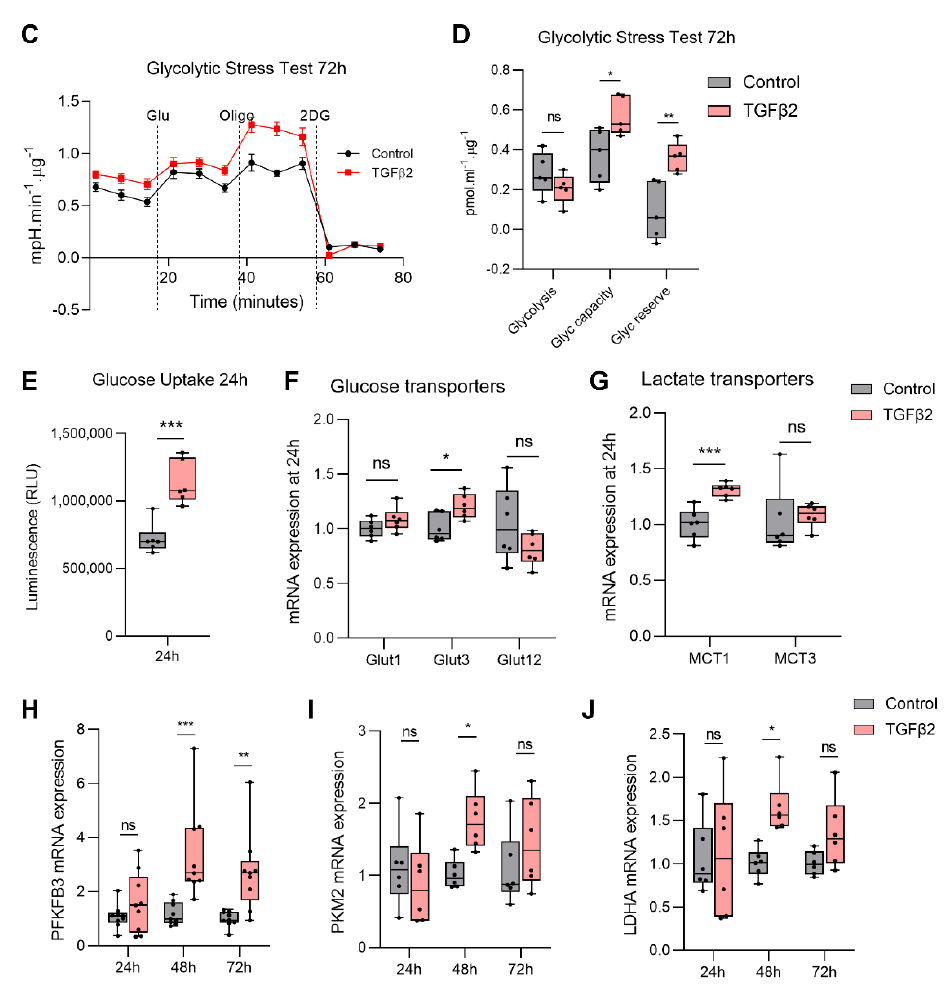
Figure 3. TGF β 2 enhances glycolytic reserve in RPE and increases glycolysis gene expression. Real- time measurement of extracellular acidification rate (ECAR) using the Seahorse XF24 BioAnalyzer to assess glycolytic function parameters: glycolysis, glycolytic capacity and glycolytic reserve based on responses to drug injections of glucose (Glu), oligomycin (Oligo) and 2-deoxyglucose (2DG) at ( A , B ) 24 h ( C , D ) 72 h treated with and without TGF β 2 ( n = 5, one-way ANOVA with Tukey’s post-hoc analysis). ( E ) Glucose uptake at 24 h with or without TGFβ2 ( n = 6, unpaired t -test) in relative light units (RLU). qPCR analysis of ( F ) glucose transporters at 24 h, ( G ) lactate transporters at 24 h and glycolysis gene expression ( H ) PFKFB3 , ( I ) PKM2 and ( J ) LDHA at 24, 48 and 72 h with or without TGFβ2 ( n = 9 for PFKFB3 otherwise n = 6, one-way ANOVA with Tukey’s post-hoc analysis). Error bars are means ± SEM. * p ≤ 0.05; ** p ≤ 0.01; *** p ≤ 0.001; ns, not significant.